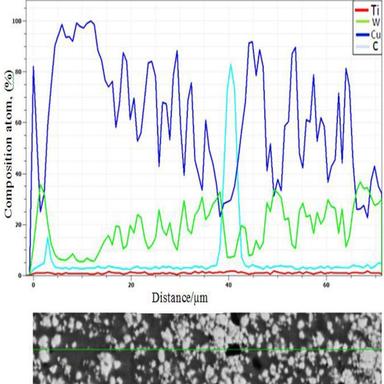
Compositional line profiles for the Cu/WC-TiC-Co composite reinforced with 1 wt% GNs.